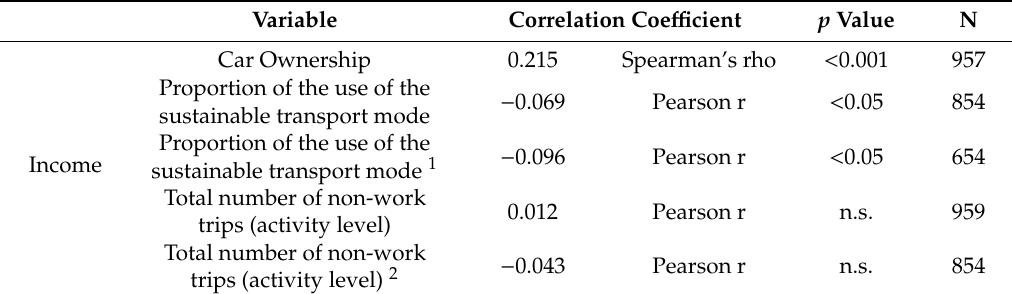
Table 9. Relationship Between Income, Car Ownership and the Proportion of the Use of the Sustainable Transport Mode and the Total Number of Non-Work Trips (annual